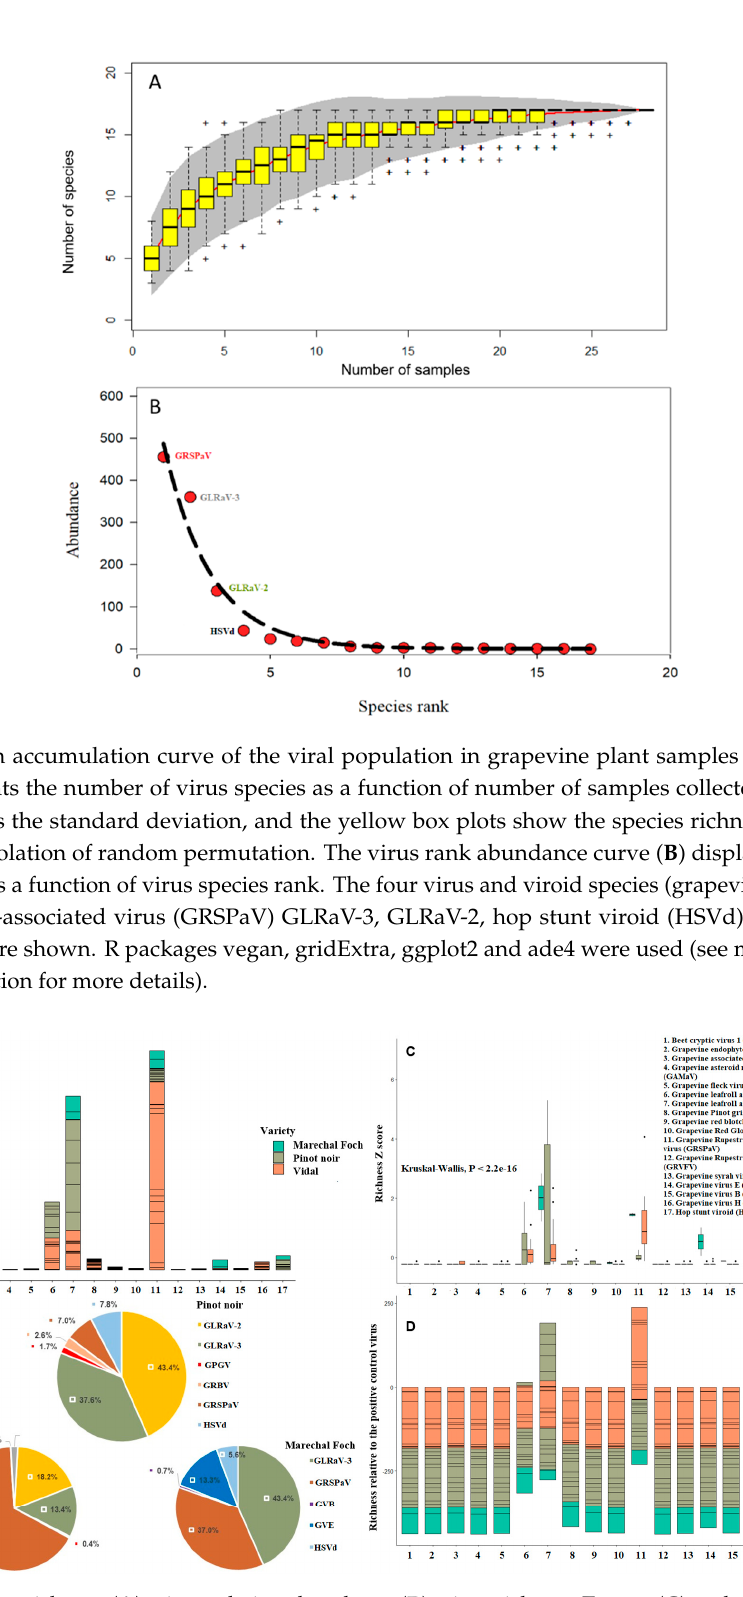
Figure 3. Virus richness ( A ), virus relative abundance ( B ), virus richness Z score ( C ) and virus richness relative to the richness of the positive control ( Phaseolus vulgaris endorvirus1 (PvEV1)) ( D ), sorted by the three major grapevine cultivars that constituted 93% of the total plants sampled (Marechal Foch, Pinot noir and Vidal). R package ggplot2 was used (see materials and methods section for details on how richness and richness Z score were calculated).